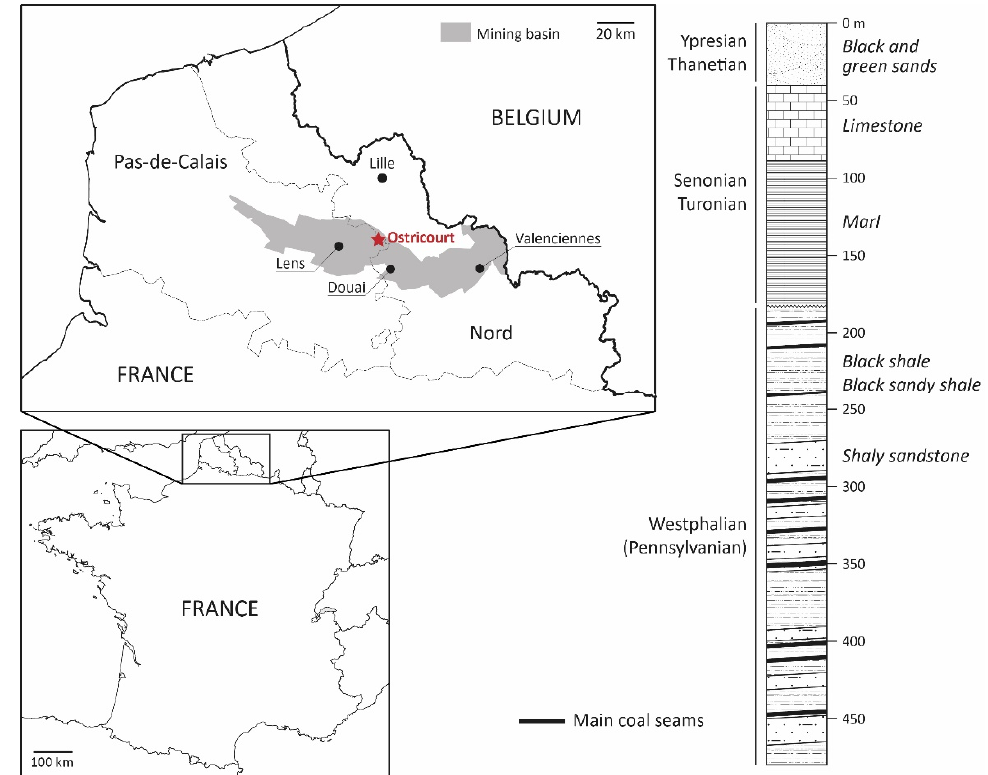
Figure 1. Location of the mining basin of the Northern France, and of the Ostricourt well ( fosse 7-7bis ) and spoil stip. Stratigraphic log, established from H.N. Groupes d’Oignies drilling report.